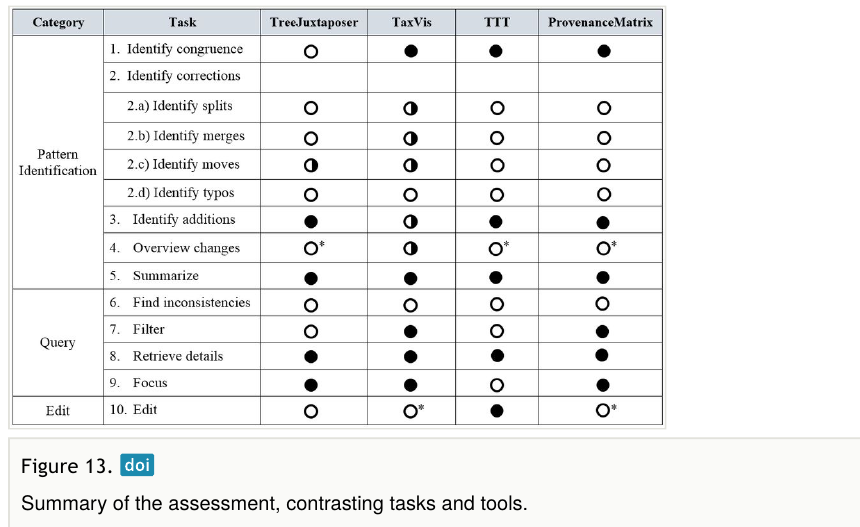
Summary of the assessment, contrasting tasks and